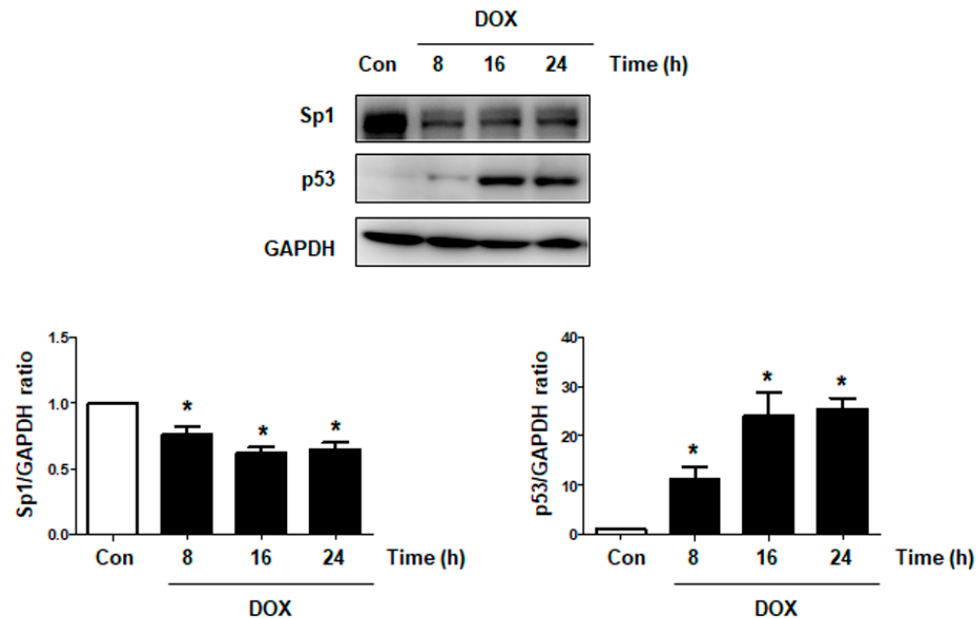
Figure A5. DOX regulates the expression of Sp1 and p53 in cardiomyocytes. H9c2 cells were treated with DOX (1 μ M) for the indicated time periods. The protein levels of Sp1, p53, and GAPDH were measured by Western blotting ( n = 5). * Significant difference compared to the control ( p < 0.05).